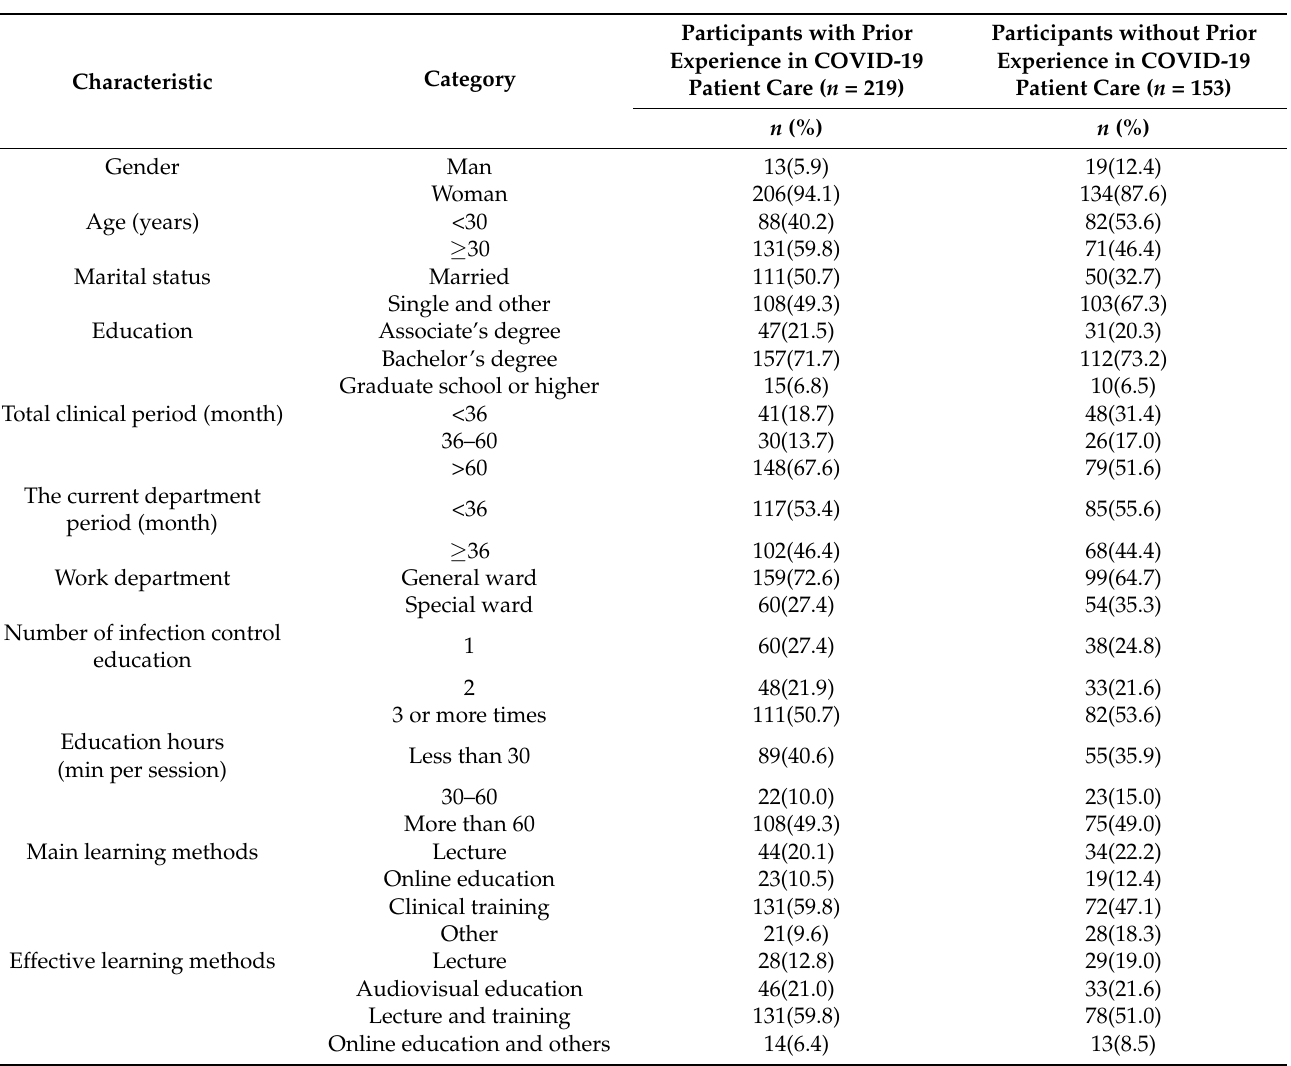
Table 1. Characteristics of